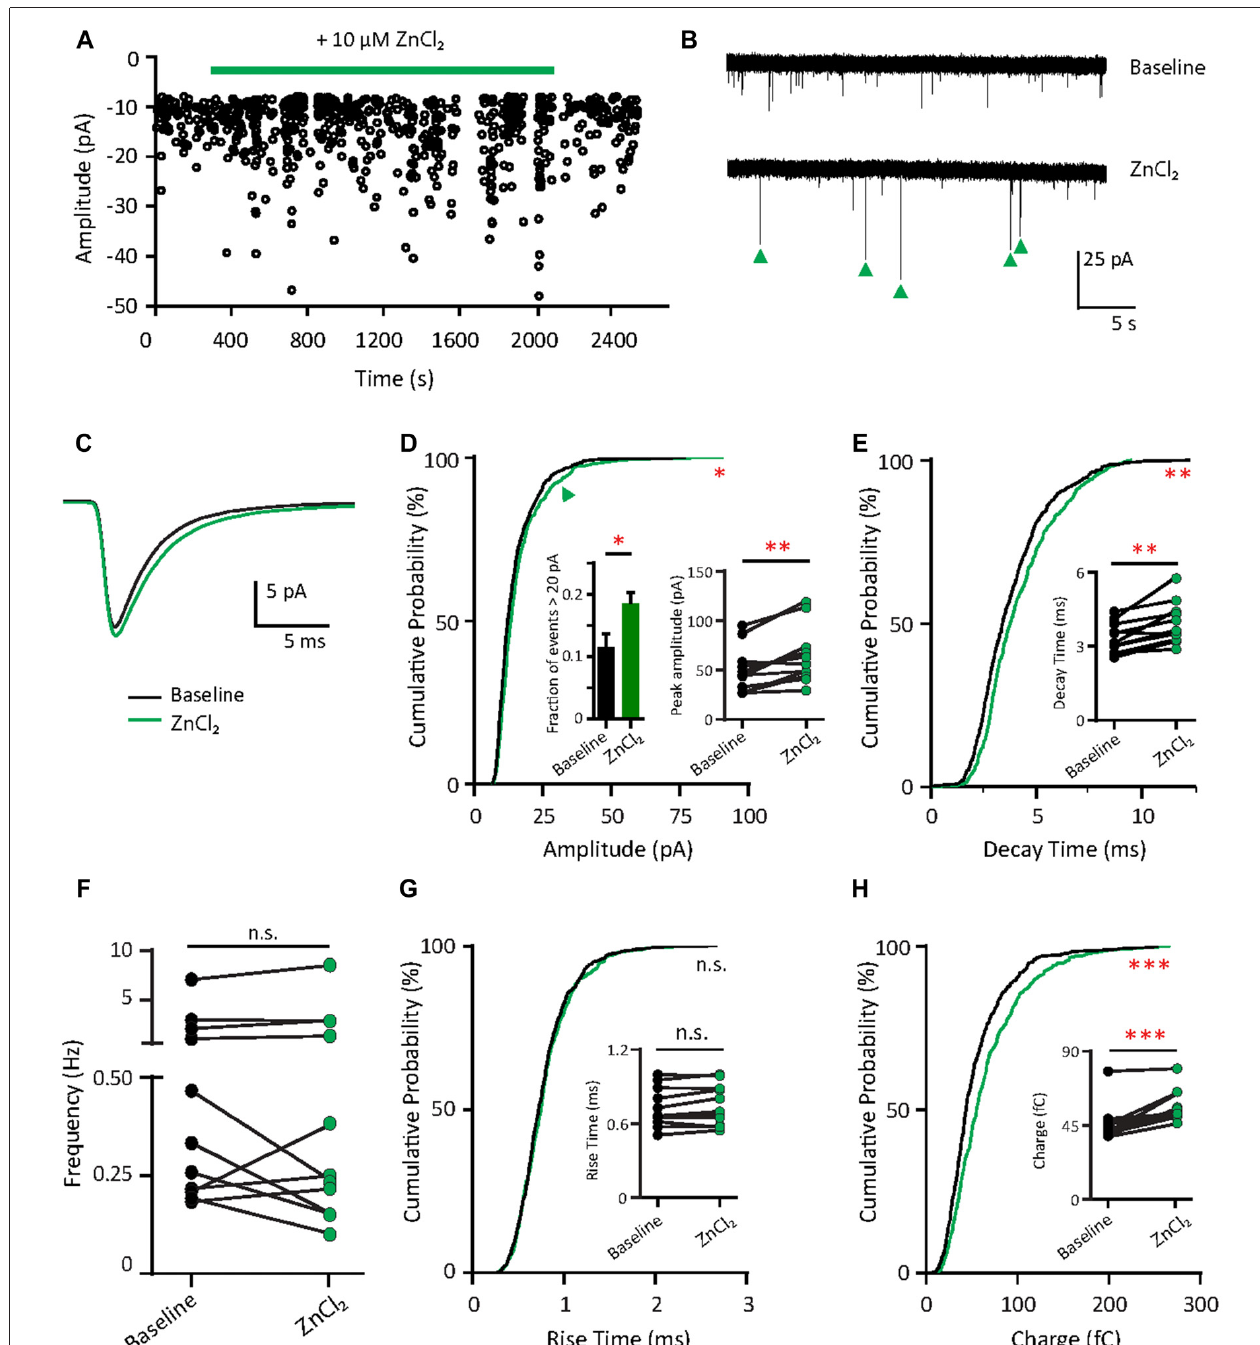
FIGURE 4 | Zinc treatment enhances synaptic efficacy of AMPAR mEPSCs in young neurons. (A) AMPAR mEPSCs were recorded from a young hippocampal neuron (DIV 11). Green bar: 10 µ M ZnCl 2 application. (B) AMPAR mEPSC recording traces from the neuron shown in (A) at baseline (top) and during ZnCl 2 (bottom). Green arrowheads mark the events with larger amplitude during ZnCl 2 treatment. (C) Ensemble-averaged mEPSCs from the baseline and zinc conditions measured in the same neurons (baseline: black, ZnCl 2 : green, N = 11 cells from seven culture preps, which applies to all subsequent panels unless otherwise specified). (D,E,G,H) Cumulative probability histograms of amplitude (D) , decay time (E) , rise time (G) and charge (H) of isolated events from baseline (black) and ZnCl 2 (green) conditions (K.S. test, N = 600 events. n.s. p ≥ 0.005, ∗ p < 0.005, ∗∗ p < 0.001, ∗∗∗ p < 0.0001). First inset in (D) : summary graph showing the difference of fraction of events with amplitude > 20 pA between baseline and ZnCl 2 conditions. All other insets show per-cell-basis pairwise comparison of amplitude (D) , decay time (E) , rise time (G) and charge (H) between baseline and ZnCl 2 conditions (Wilcoxon test, n.s. p ≥ 0.05, ∗∗ p < 0.01, ∗∗∗ p < 0.001). (F) Pairwise comparison of AMPAR mEPSC frequency between baseline and ZnCl 2 conditions (Wilcoxon test, n.s. p ≥ 0.05).